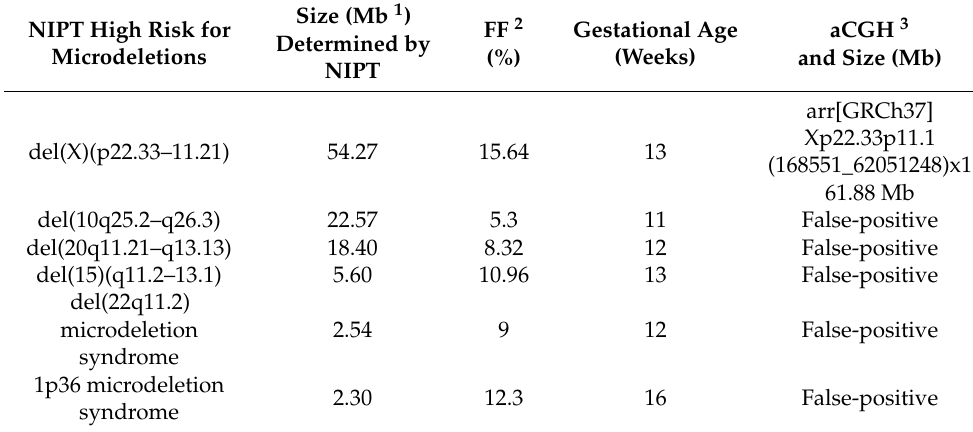
Table 5. Description of cases at risk for